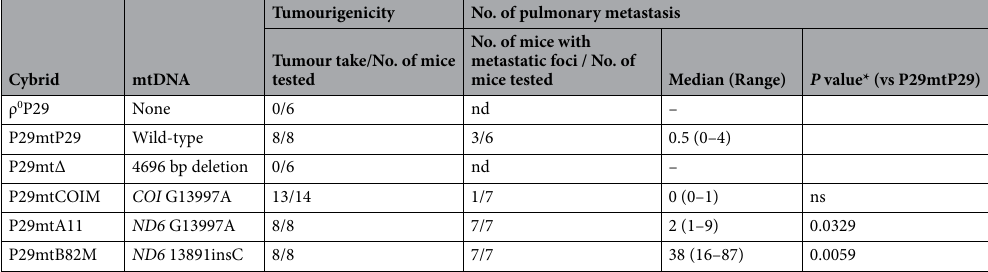
Table 1. Tumourigenicity and metastatic potential of the P29 cybrids used in this study. nd, not detected; ns, not significant. *Mann–Whitney U